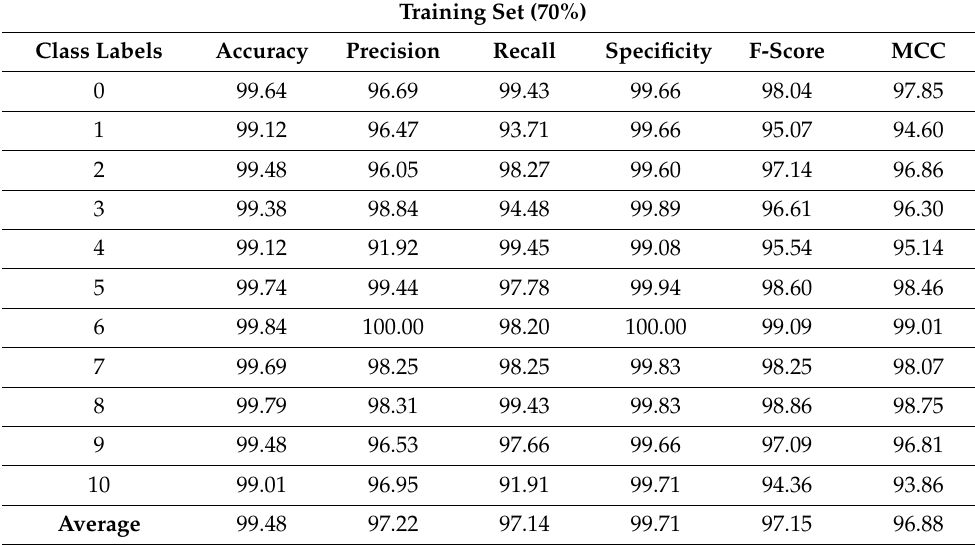
Table 3. Result analysis of SFODLD-SAC technique with distinct measures on 70% of TRS.